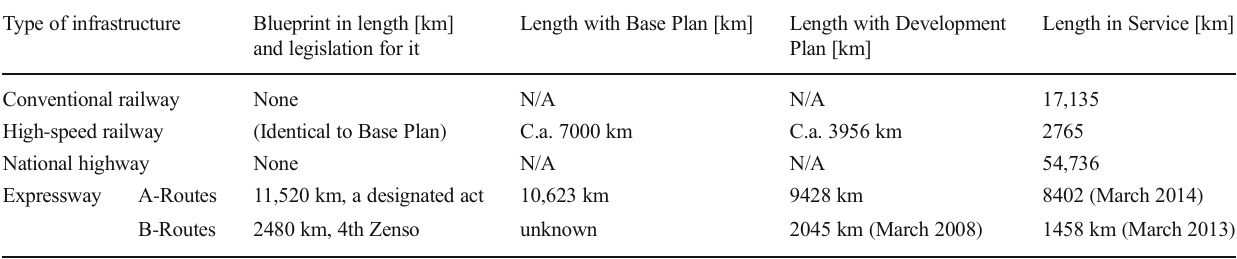
Comparison of legally-binding network length, planned length and length in service Type of